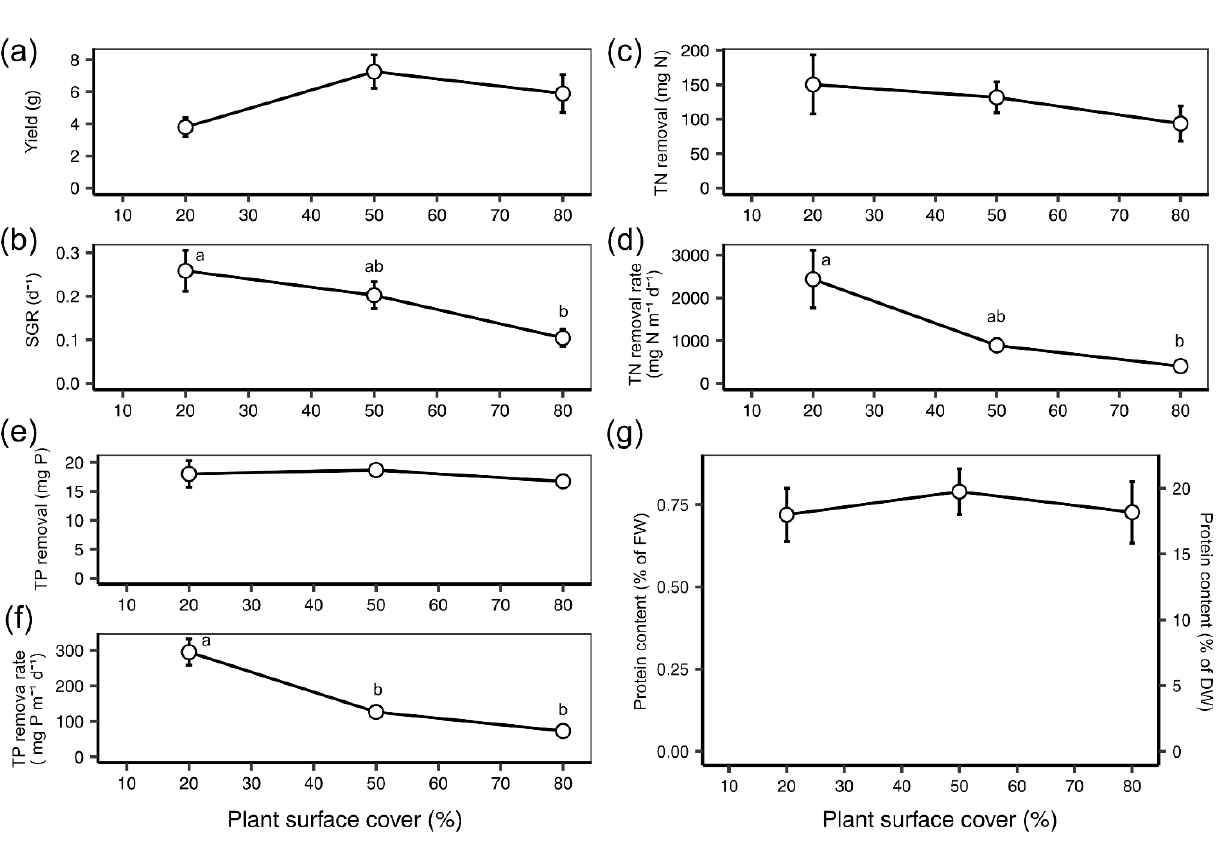
Figure 5. Mean (± SE) ( a ) yield (g), ( b ) SGR (d −1 ), ( c ) TN removal (mg N), ( d ) TN removal rate per frond surface area (mg N m −2 d −1 ), ( e ) TP removal (mg P), ( f ) TP removal rate per frond surface area (mg P m −2 d −1 ) and ( g ) % protein content based on fresh duckweed biomass, FW, and dry duckweed biomass, DW, for L. minor grown on synthetic wastewater in a re-circulating system at three plant surface covers (20, 50 and 80 %) over 5 days. Points that do not share the same letter significantly differ from one another, as per the Tukey post hoc test, p < 0.05.